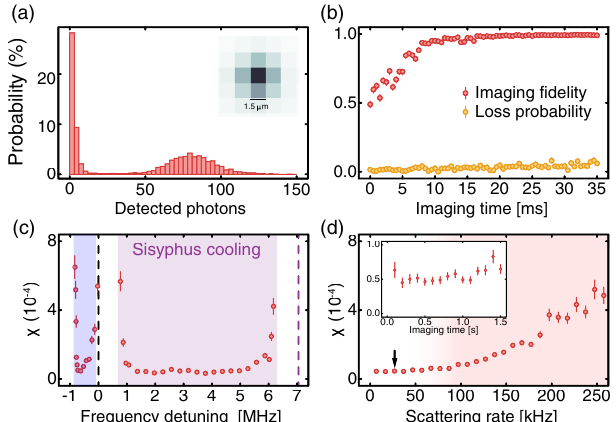
FIG. 2. Imaging in a single tweezer. (a) Histogram of detected photons acquired under typical imaging conditions, showing good discrimination between a zero-atom and single-atom